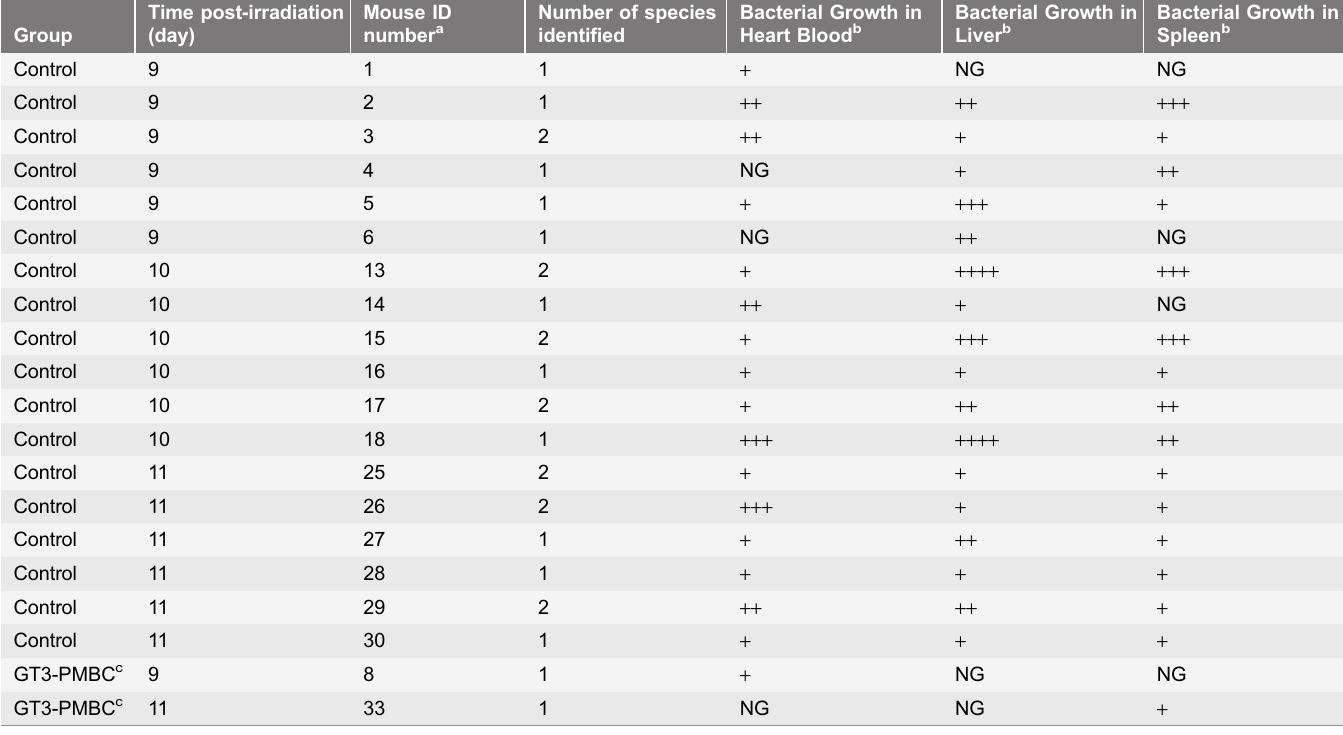
a At each time point, n 5 6 mice sampled per treatment group. b + indicates the relative concentration of bacterial colonies in the first quadrant only of the agar isolation medium, using the four-dilution streak method, ++++ indicates bacterial growth in the fourth quadrant of the plate, farthest from the primary inoculation, indicating the highest concentration of bacteria. NG 5 no growth. The GT3-PBMC mice, in which no bacteria were detected in tissues, were not included in the